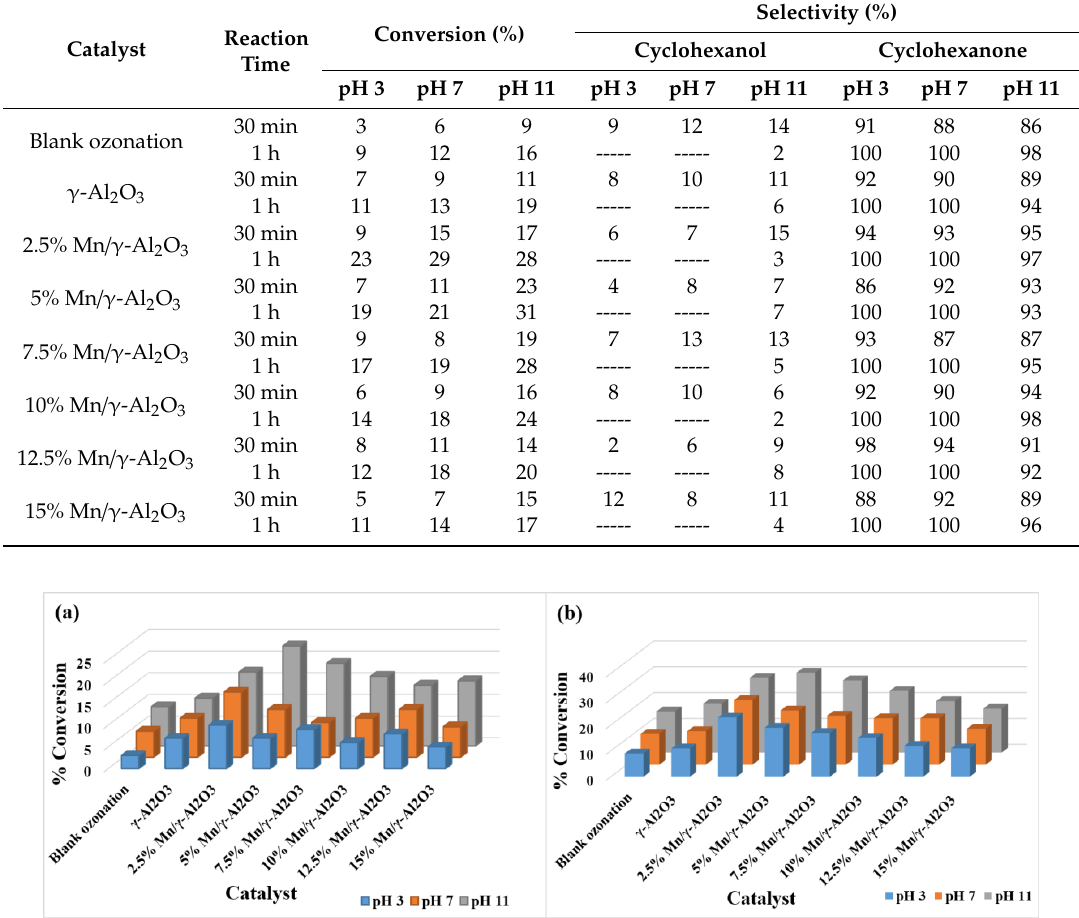
Table 3. Cyclohexane percentage conversion and selectivity toward KA oil at 20 ± 1 ◦ C and 1 atm. Reaction Catalyst